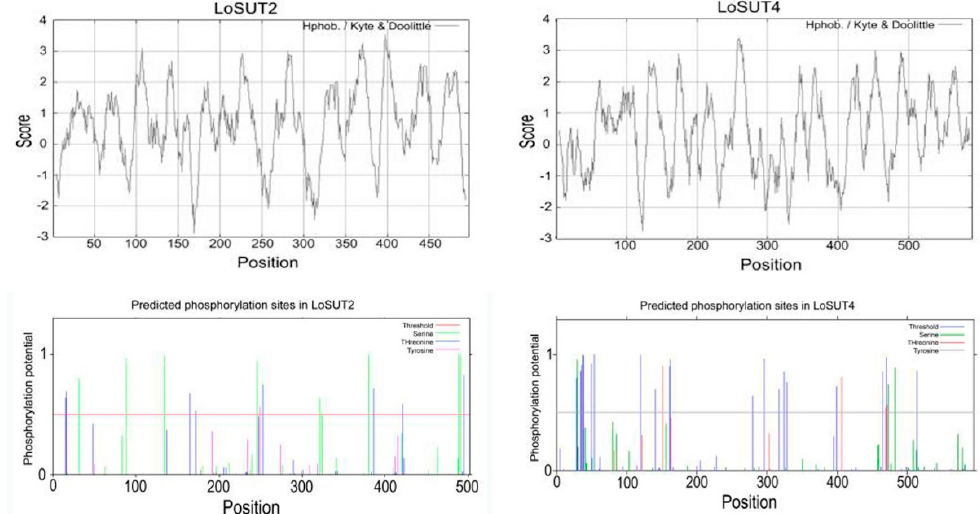
Figure 8. Hydrophobic cluster and signal peptide analysis of LoSUT2 and LoSUT4. The amino acid sequences were arranged horizontally. The hydrophobic site was located above the zero line, while the hydrophilic site was located below the zero line. The horizontal axis represents the amino acid, and the vertical axis represents the probability that the amino acid of that position was phosphorylated.